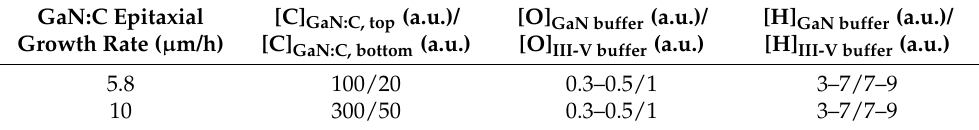
Table 1. Atomic content in the buffer layers as a function of the GaN:C epitaxial growth rate. GaN:C